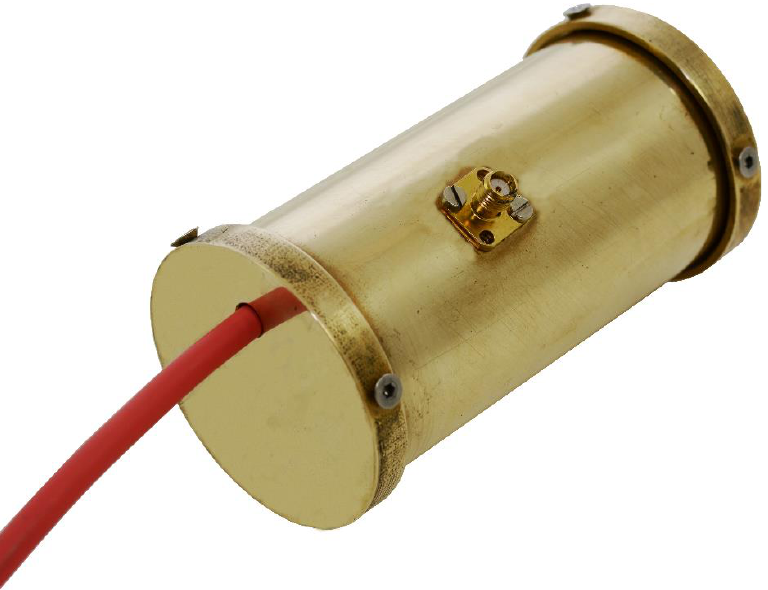
Figure A3. Photo of the built resistive voltage divider in brass housing with high-voltage cable for input signal.